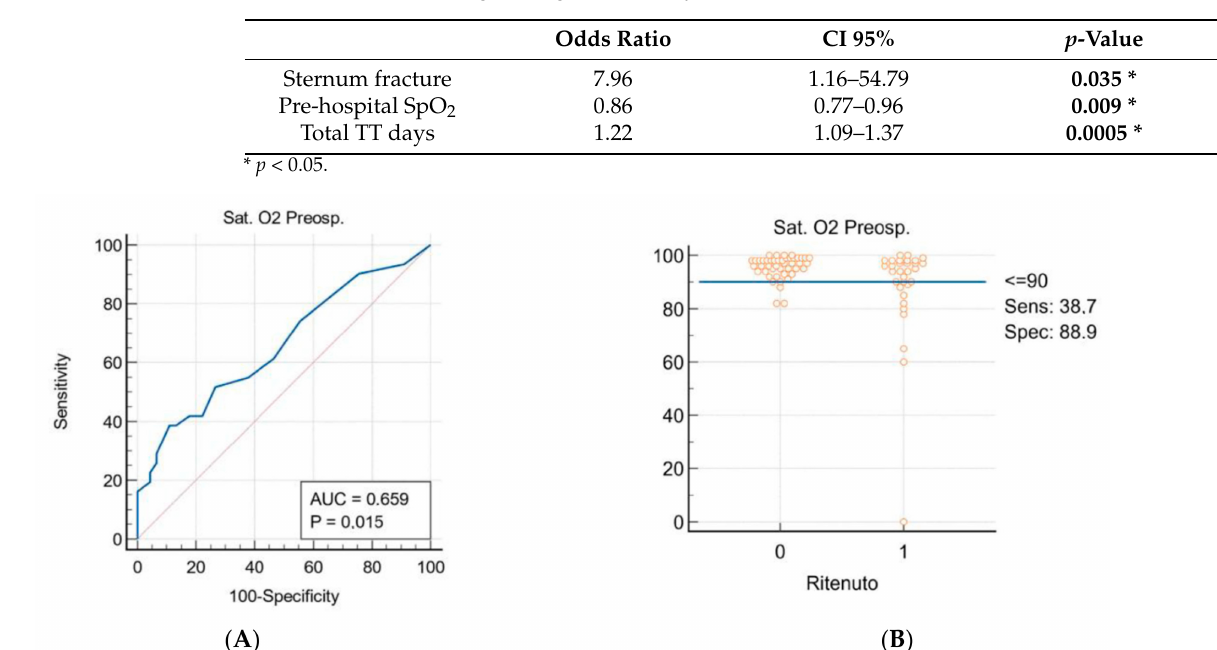
Table 2. Multivariate logistic regression analysis.